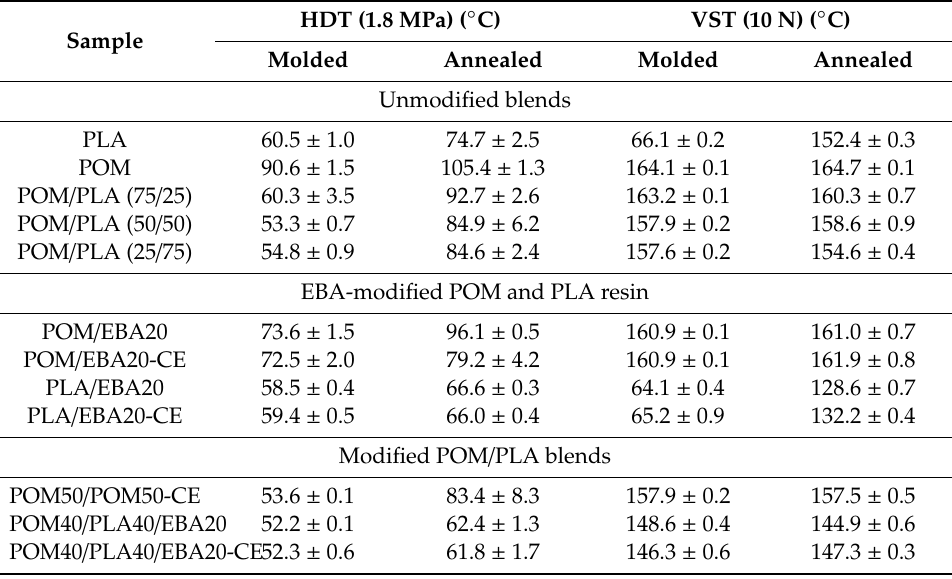
Table 1. The results of thermomechanical measurements, namely, heat deflection temperature (HDT) and Vicat softening temperature